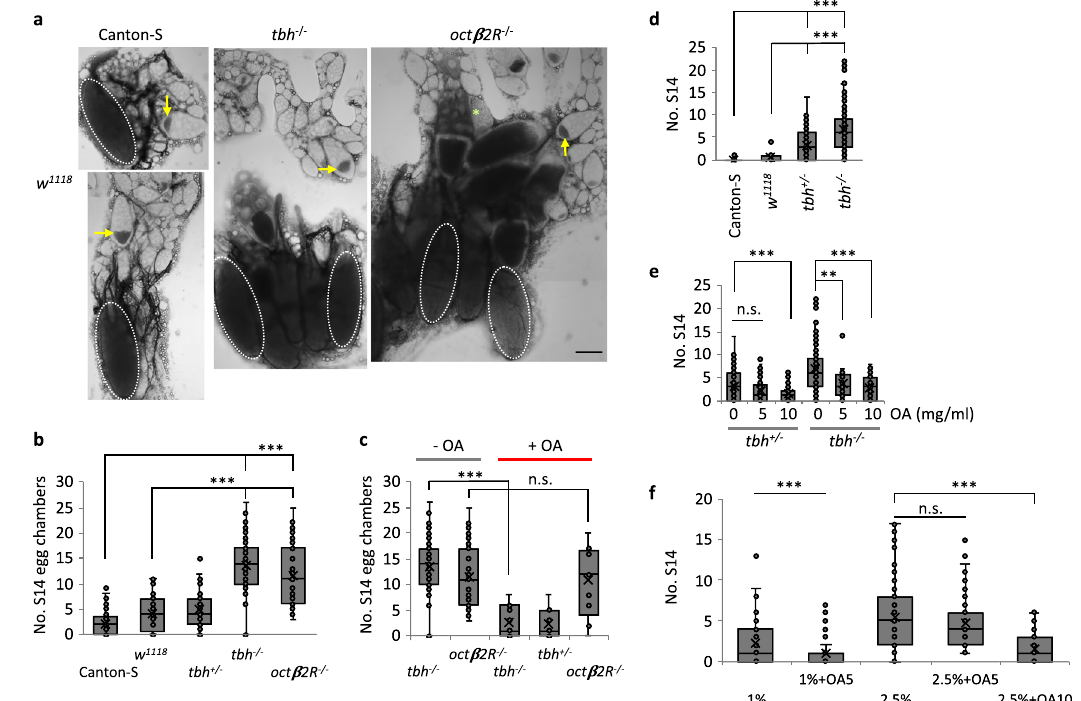
Fig. 6 Octopamine regulates quiescence via Oct β 2R, competing with nutrients. a , b Upon protein starvation, tbh − / − or oct β 2R − / − virgins contain more stage 14 egg chambers (S14, white dotted ellipses) than controls. Representative images (Scale bar = 100 µ m) ( a ) and the quanti fi cation ( b ). Arrows indicate stage 9. n = 85 tbh − / − ; 35 oct β 2R − / − ; 137 Canton-S; 52 w 1118 ; 47 tbh + / − . Two-sided t -test: p = CS vs. w 1118 (0.0001); vs. tbh + / − (1.2 × 10 − 6 );